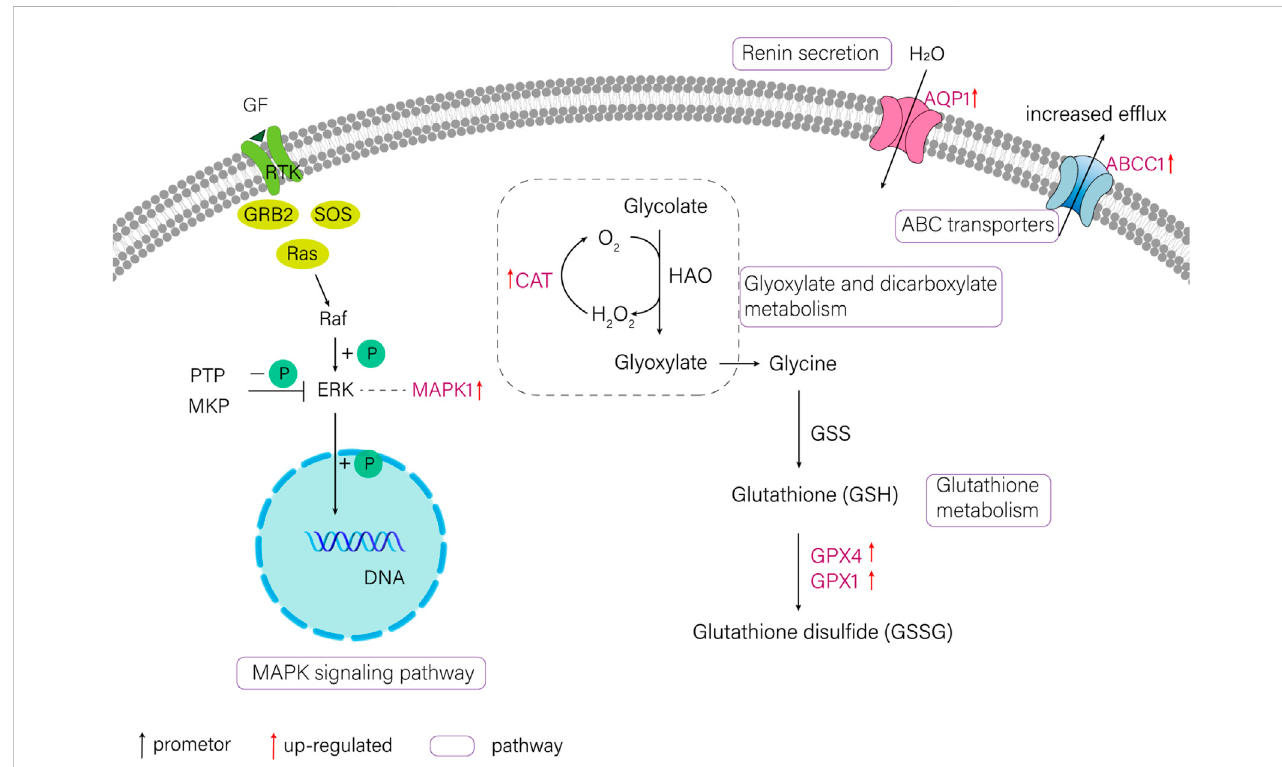
FIGURE 3 The schematic diagram ofseveral pathways aboutsalinity-alkalinity adaptation of T. yarkandensis . CAT(catalase), GPX1 (glutathione peroxidase 1),GPX4 (glutathione peroxidase 4), MAPK1 (mitogen-activated protein kinase 1), AQP1 (aquaporin-1), ABCC1 (ATP-binding cassette, subfamily C (CFTR/MRP), member